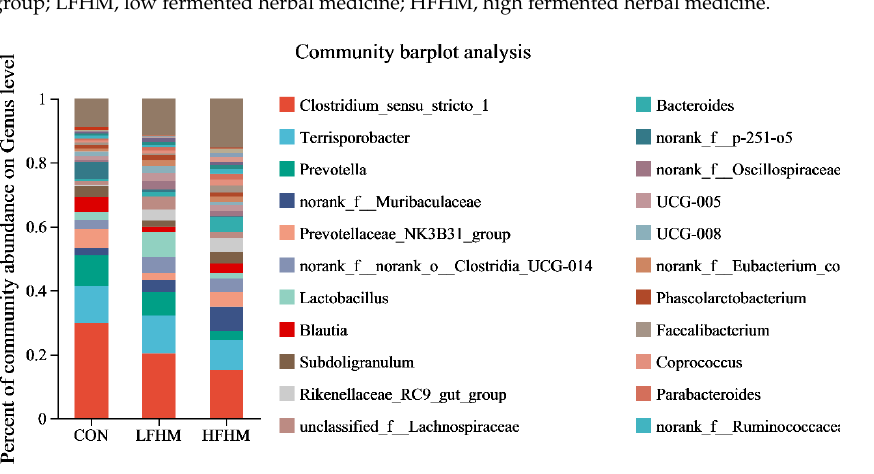
Figure 1. Effects of different amounts of fermented Chinese herbal medicine on the OTU of colon microflora in growing pigs. CON, basal diet group; CON, control group; LFHM, low fermented herbal medicine; HFHM, high fermented herbal medicine.